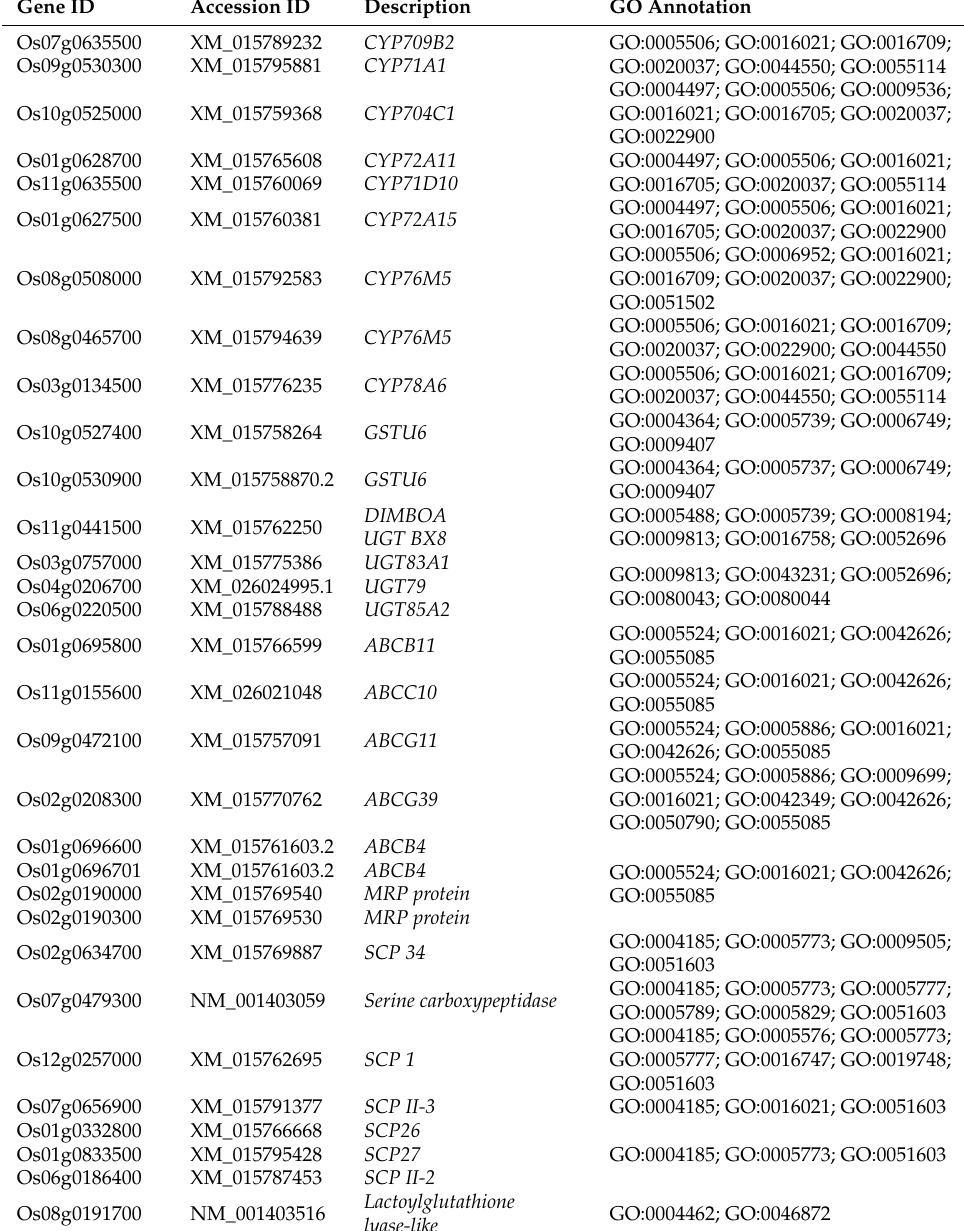
Table 1. Potential fenoxaprop-P-ethyl metabolic genes in